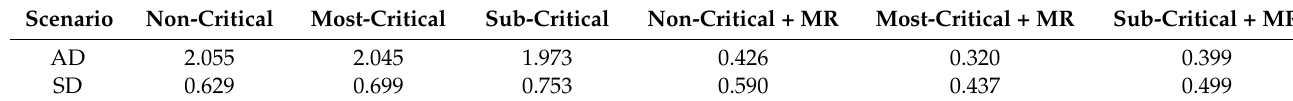
Table 4. Average (AD) and standard deviation (SD) of visual reaction time (seconds).